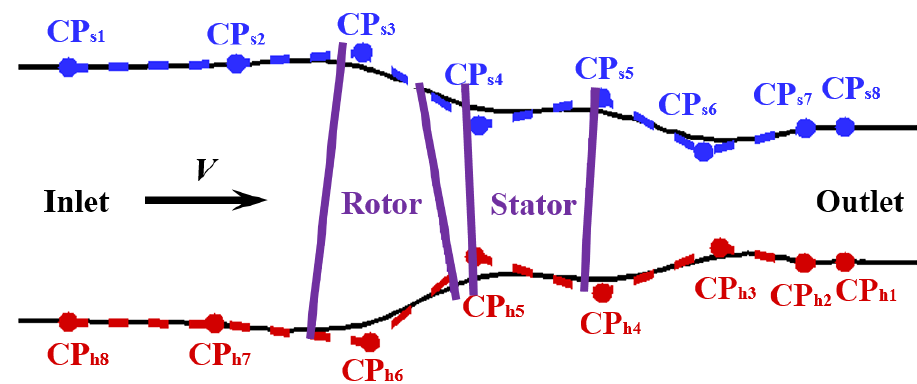
Figure 9. The schematic diagram of the control points’ locations.